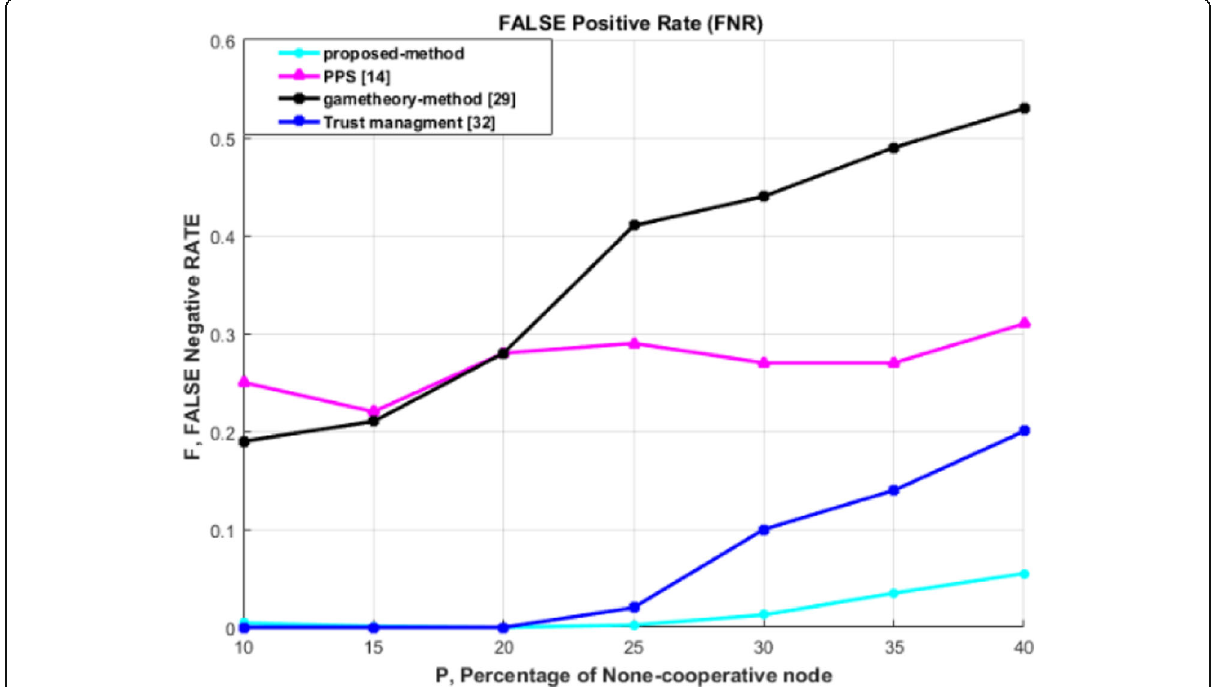
Fig. 10 Comparison of the different algorithm in false-positive rate (FPR)